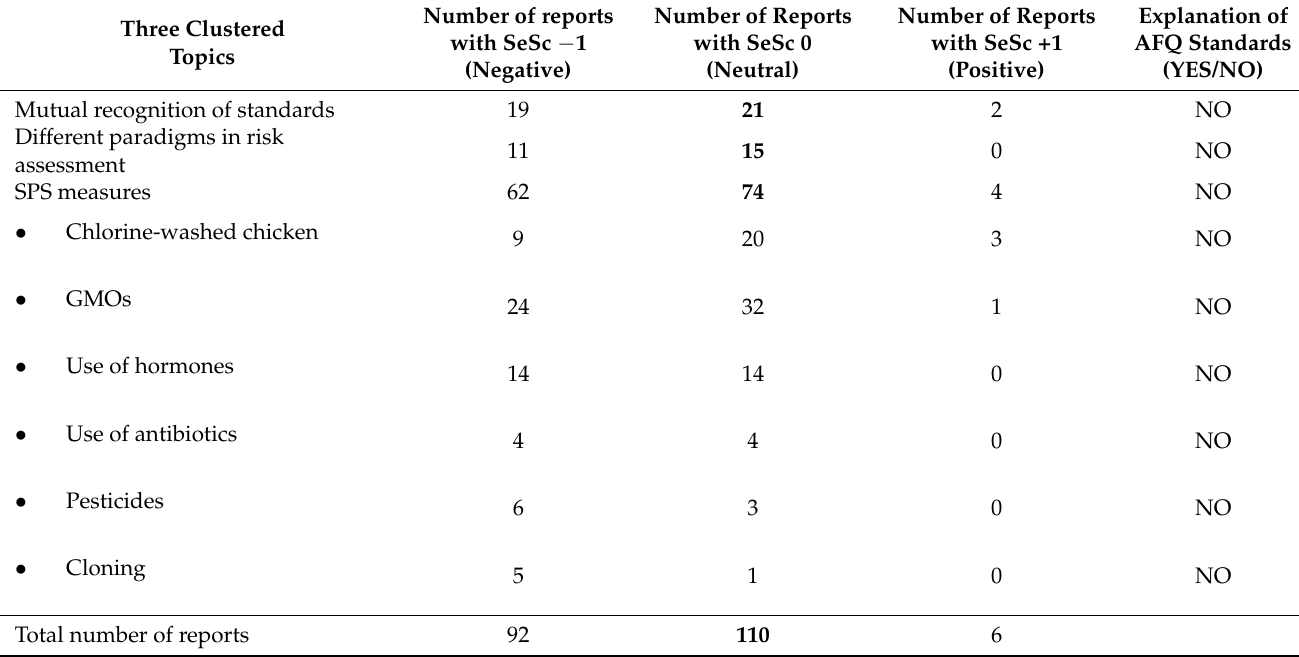
Table 4. Overview of the qualitative sentiment analysis of media reports (TV and radio) on the three clustered topics and assessment on their explanations regarding specific AFQ standards.